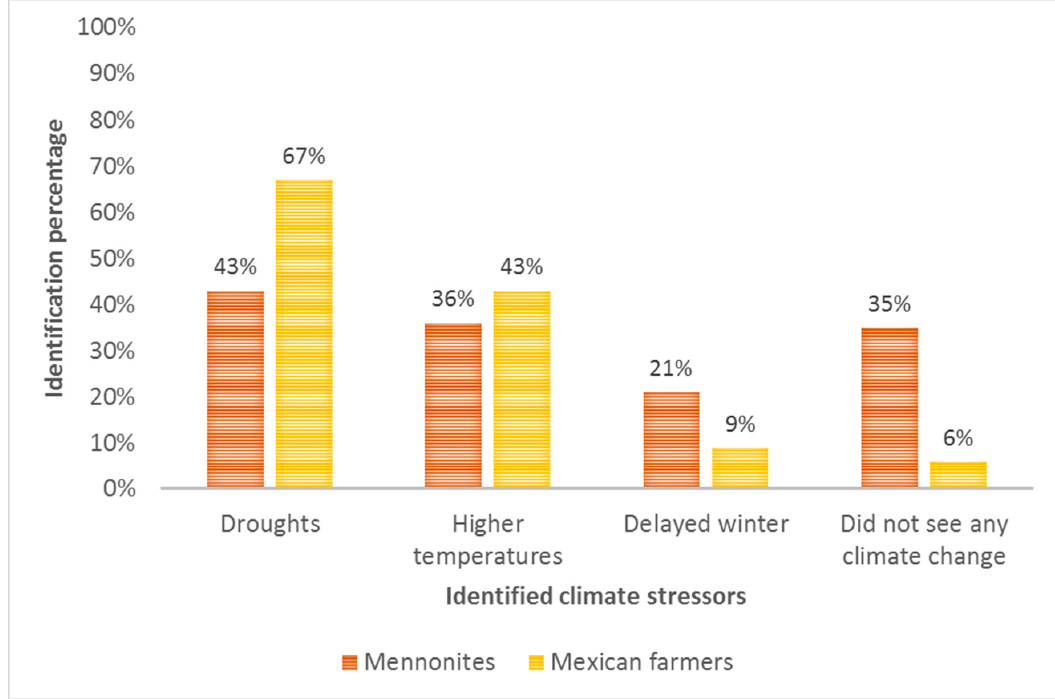
Figure 4. Survey results when the 217 participants were asked if they had seen any change in the climate conditions in the Rio del Carmen watershed between 1997 and 2017. climate conditions in the Rio del Carmen watershed between 1997 and